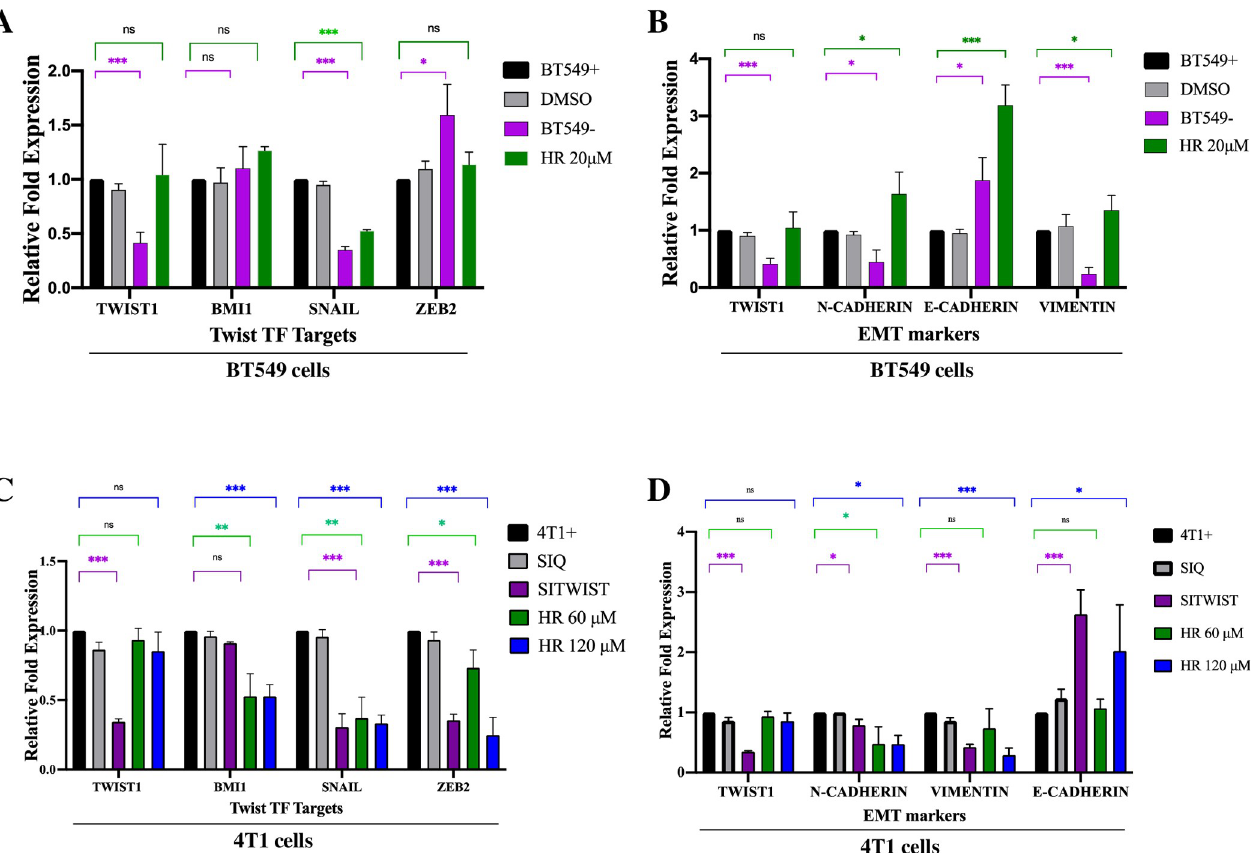
Fig 6. Harmine treatment does not affect the level of Twist1 transcripts in breast cancer cells. A, Analysis of the expression of Twist1 and its target genes in BT549 cells. BT549 Twist+ cells were either untreated (BT549+), treated with DMSO (DMSO) or harmine (HR 20 μ M) for 48 hr, and the levels of Twist1 mRNA were determined by RT-qPCR (see Materials and Methods). BT549 Twist- cells (BT549-) were included as a negative control. The mRNA levels of Twist1 and its target genes Bmi1 (BMI1), Snail (SNAIL) and ZEB2 (ZEB2) were normalized against that of β -actin, tubulin α 1a and GAPDH. B, The expressions of EMT markers N-Cadherin (N-CADHERIN), E-Cadherin (E-CADHERIN) and Vimentin (VIMENTIN) were analyzed with the same samples as in A. C, Analysis of the expression of Twist1 and its target genes in 4T1 cells. The 4T1 Twist+ cells were either untreated (4T1+), transfected with scrambled control siRNA (SIQ), transfected with Twist1 siRNA (SITWIST) (negative control), treated with 60 μ M harmine (HR 60 μ M) or treated with 120 μ M harmine (HR 120 μ M). mRNA levels for Twist1 and its target genes Bmi1 (BMI1), Snail (SNAIL) and ZEB2 (ZEB2) were measured by RT-qPCR. All results were normalized against the mRNA levels of β -actin, tubulin α 1a and GAPDH. D, The expressions of EMT markers N-Cadherin (N-CADHERIN), E-Cadherin (E-CADHERIN) and Vimentin (VIMENTIN) were analyzed with the same samples as in C. All data were pooled from three independent experiments. Definitions of statistical significance are � p < .05, �� p < .01, ��� p < .001, and ���� p <